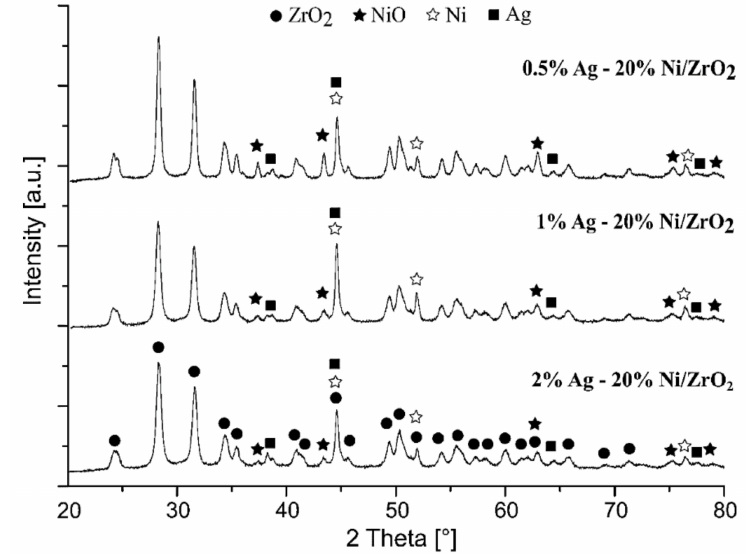
Figure 9. Powder patterns of the spent bimetallic supported catalysts in the oxy-steam reforming of LNG